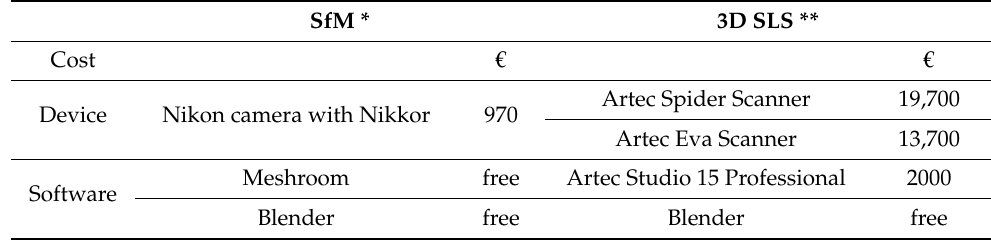
Table 8. List of hardware and software